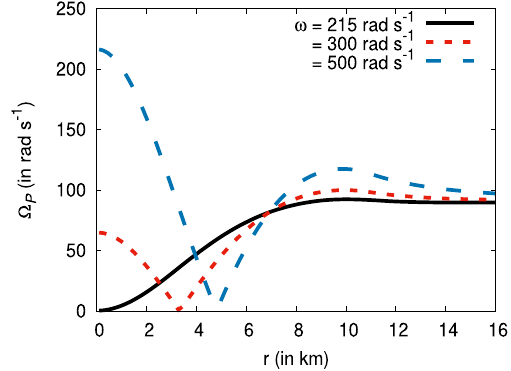
Fig. 14 Effectoftheangularvelocityofthestaron Ω P arounda1 . 5 M ◦ NS with central energy density 1 . 0 × 10 15 g cm − 3 . The solid black line, red short dashed line, and blue dashed line are for ω = 215 rad s − 1 , 300 rad s − 1 , 500 rad s − 1 respectively. Here Ω is taken to be 100 rad s −